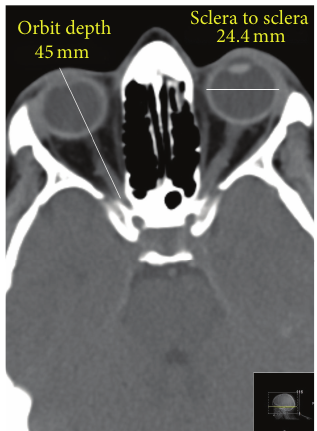
Figure 1: The retina to retina transverse diameter of the eye measured by computed